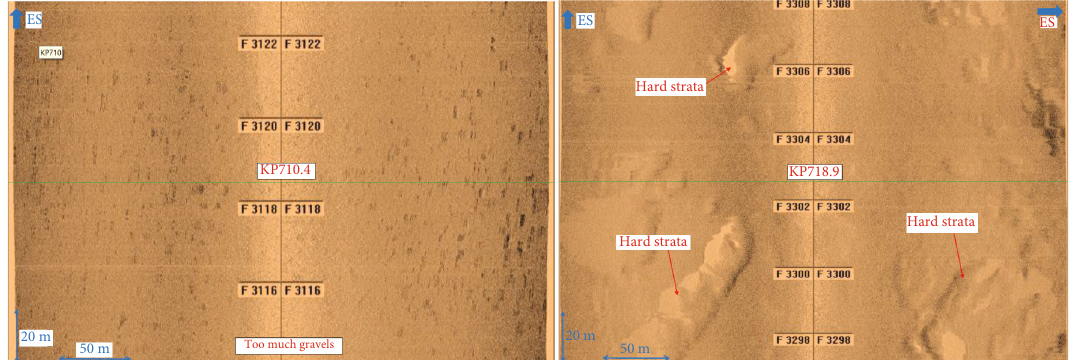
Figure 21: Side-scan sonar images showing a large number of gravels and hard strata outcropping in the area of the trench and the accompanying abyssal hills/seamounts in the Okinawa Trough (the left image is a side-scan image of gravels, and the right image is a side-scan image of hard strata